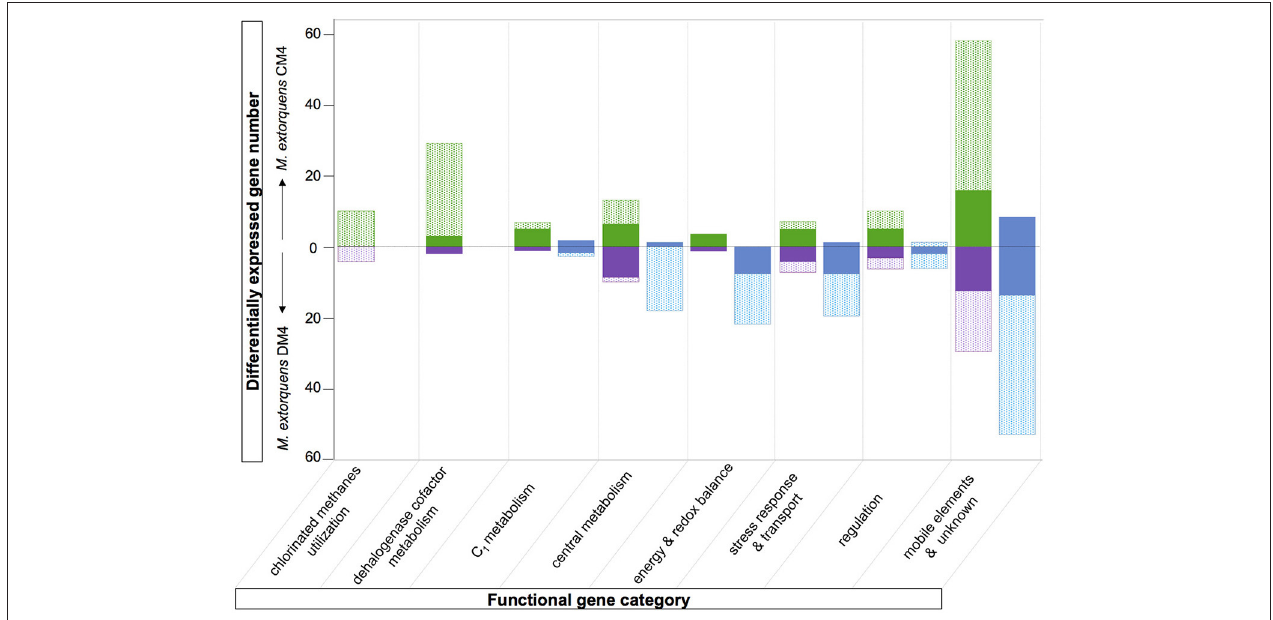
FIGURE 5 | Overview comparison of the chloromethane and dichloromethane transcriptomes. Differentially abundant genes with predicted function are clustered in different functional categories (see Tables S6, S7). The fractions of genes of the core and variable genomes are indicated in plain and dotted rectangles, respectively. Transcript with higher abundance in chloromethane, dichloromethane or methanol are in green, purple or blue,